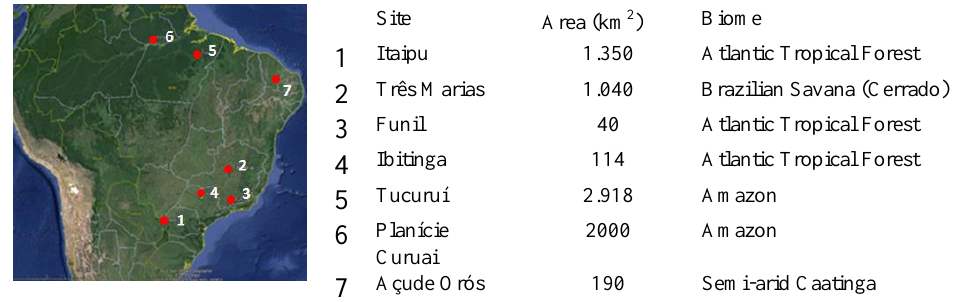
Figure 1. Geographical location sampling